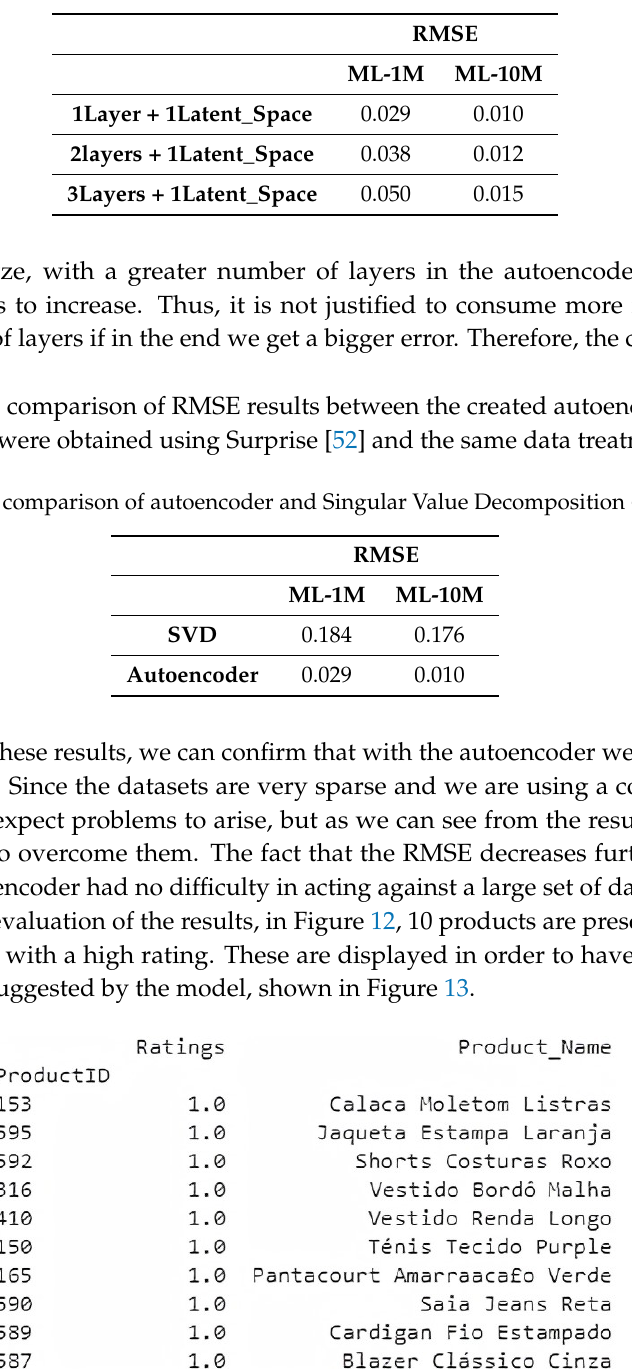
Table 3. Comparison of Root Mean Square Error (RMSE) with a different layer number in